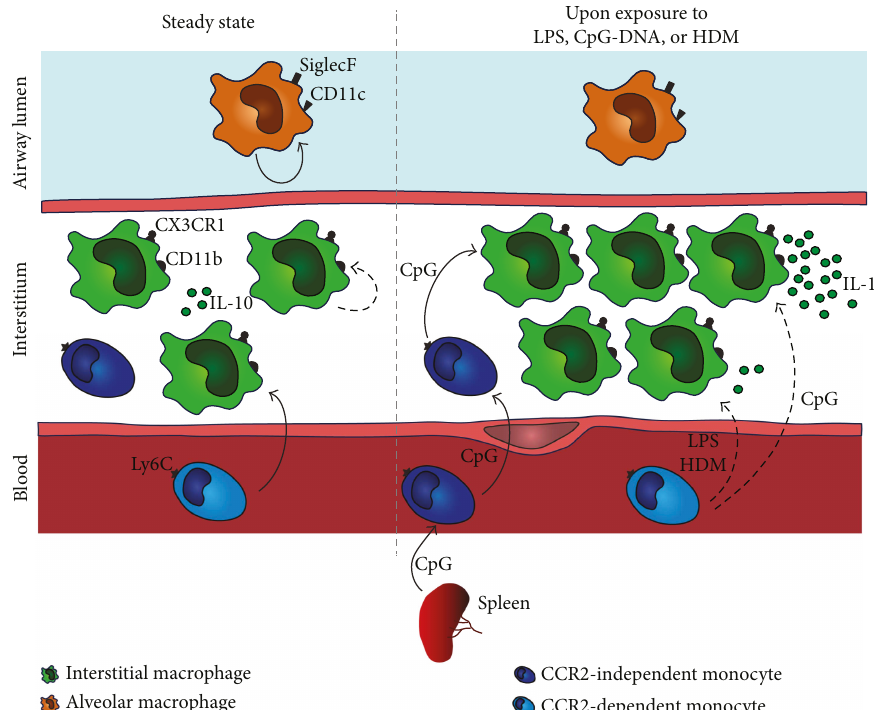
Figure 1: Mouse lung interstitial macrophage phenotype and origin at the steady state and upon exposure to LPS, CpG-DNA, or HDM. For clarity, the ratio between the numbers of depicted AM, IM, and monocytes does not re fl ect the reality. By de fi nition, IM are located in the lung interstitium, while AM reside in the airway lumen. IM can produce IL-10 at baseline, a phenomenon that is potentiated by an exposure to LPS, CpG-DNA [26], or HDM [50]. Phenotypically, IM are non-auto fl uorescent SiglecF − CD11b + CX3CR1 + Ly6C − cells, while AM are auto fl uorescent SiglecF + CD11c + CD11b − CX3CR1 − Ly6C − cells. Steady-state IM, as well as LPS- or HDM-induced IM, are thought to be maintained or expanded by the recruitment of CCR2-dependent Ly6C + classical blood monocytes, at least in part. Local proliferation may also account for the maintenance of steady-state IM. Following exposure to CpG-DNA, CCR2-independent lung-resident and splenic Ly6C + monocytes contribute to a large extent to the expansion of the IM pool endowed with enhanced immunoregulatory